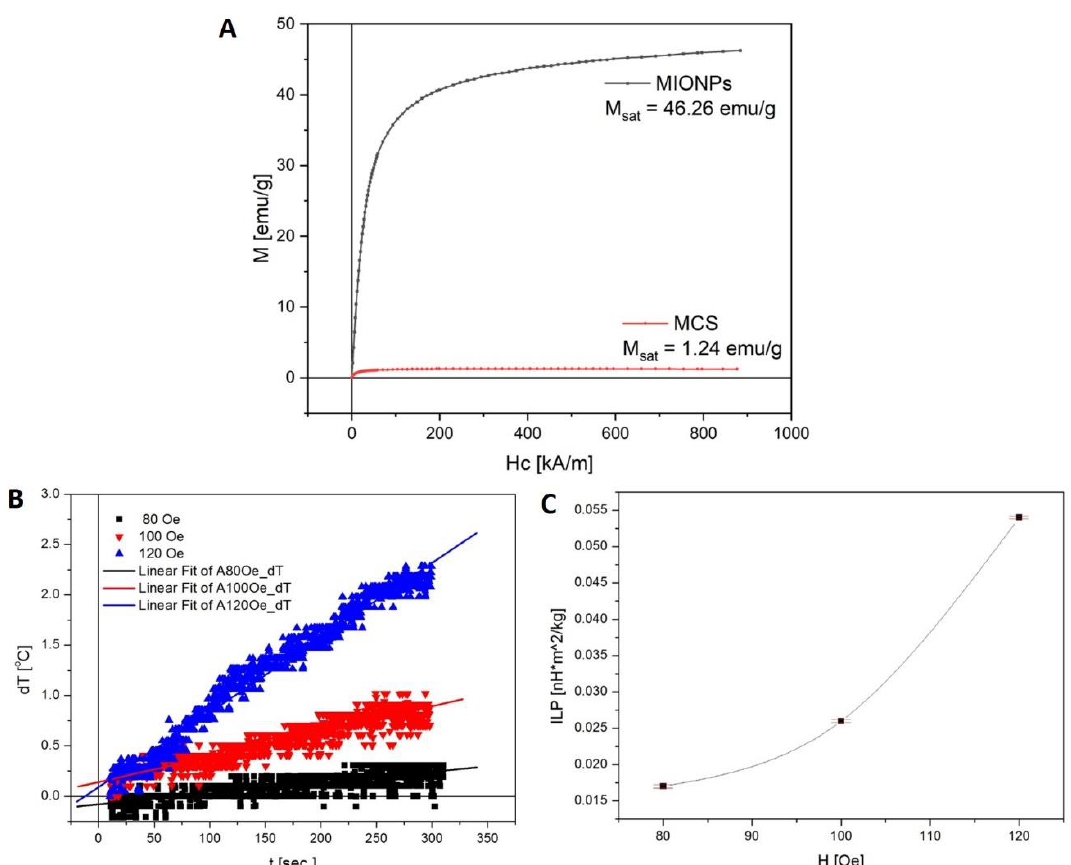
Figure 3. ( A ) Magnetization curves of MIONPs and MCS, ( B ) Time dependence of MCS temperature, increased for 80, 100, and 120 Oe HF AC magnetic field amplitudes, and ( C ) HF AC magnetic field amplitude dependence of MCS sample ILP.